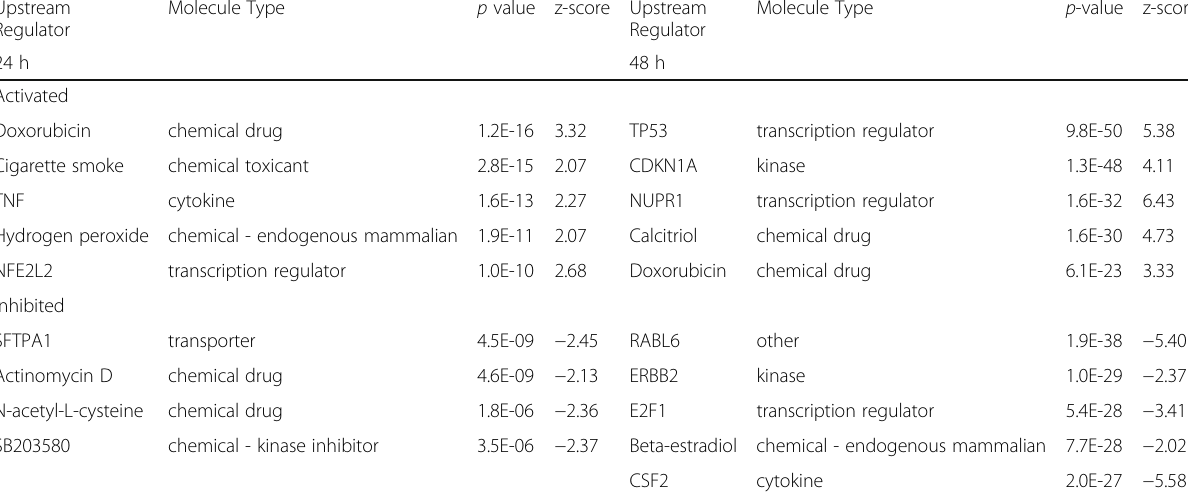
Table 3 Top URs predicted by the IPA at 24 h and 48 h after NDL treatment of MCF-7 cells Upstream Molecule Regulator